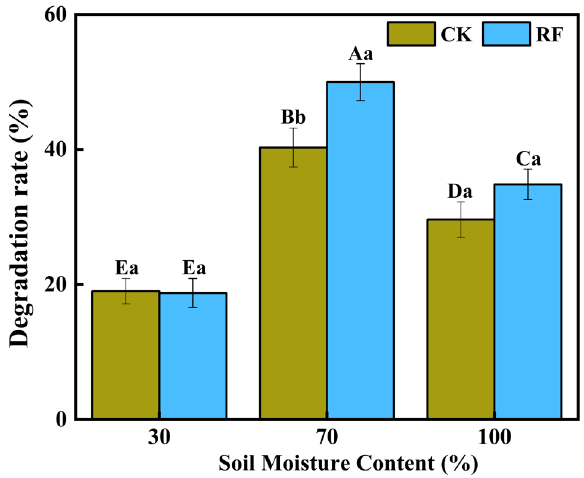
Figure 1. Comparison of the decomposition rate of straw with rumen fluid application at different SMCs (uppercase letters represent the differences between all groups, lowercase letters represent differences between the same groups, and the level of significance was set at p <